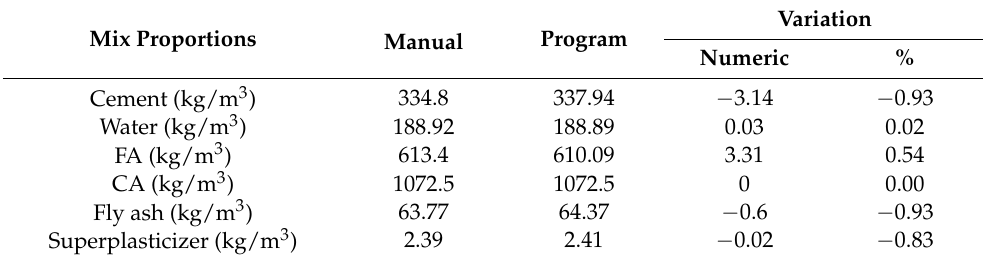
Table 1. A comparison between manual calculations and program outputs for ACI211.4R-8 method